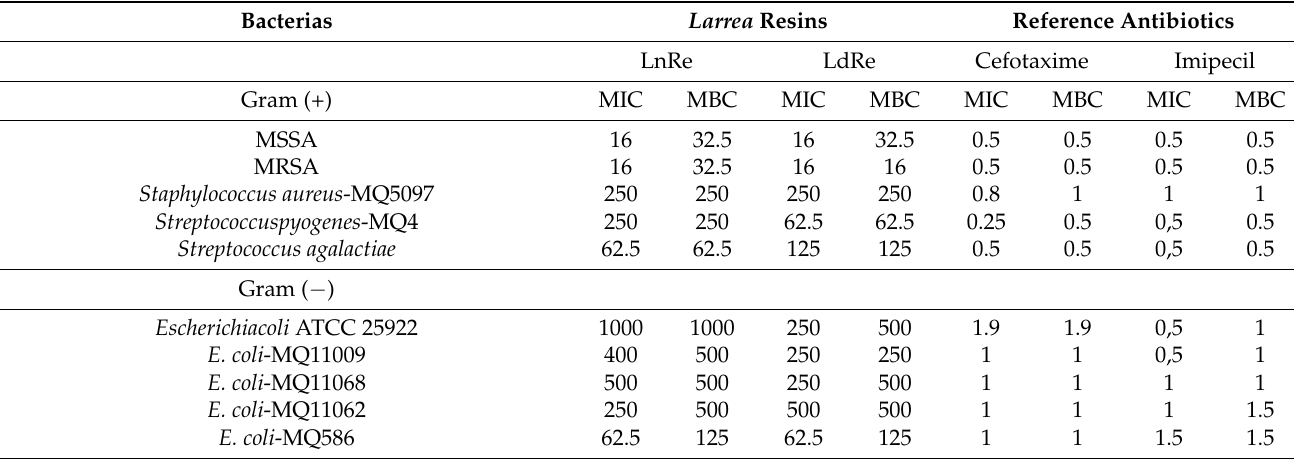
Table 4. Antibacterial activity of LdRe and LnRe resins (minimum inhibitory concentrations (MICs) and minimum bactericidal concentrations (MBCs) in µ g resin/mL).